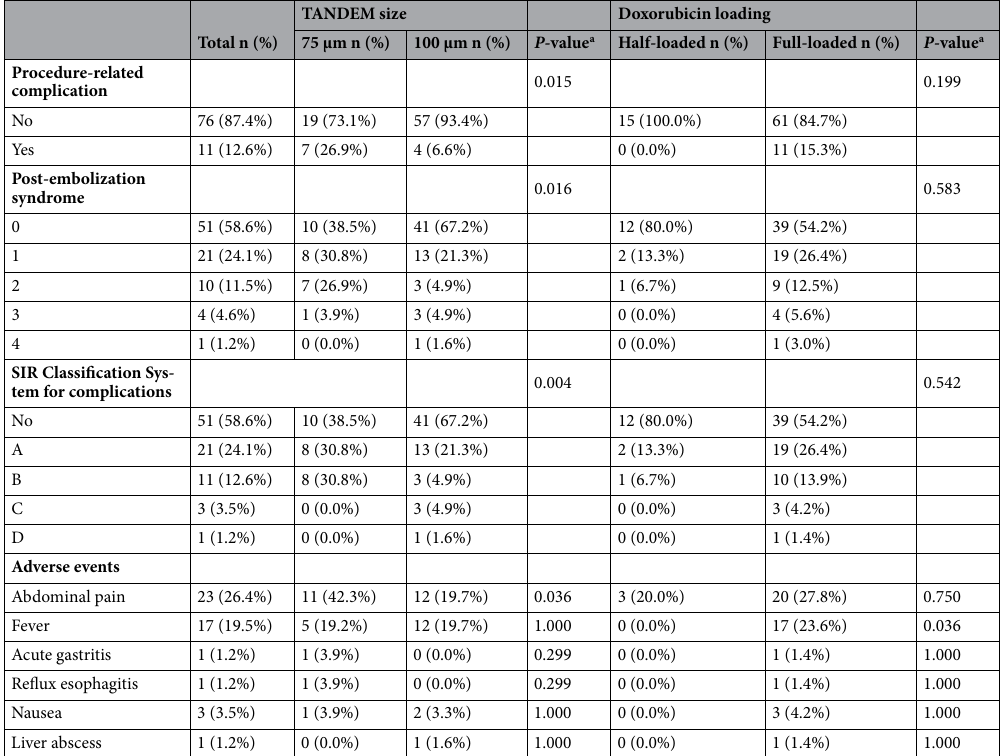
Table 3. Adverse events and complications stratified by TANDEM size and doxorubicin-loading